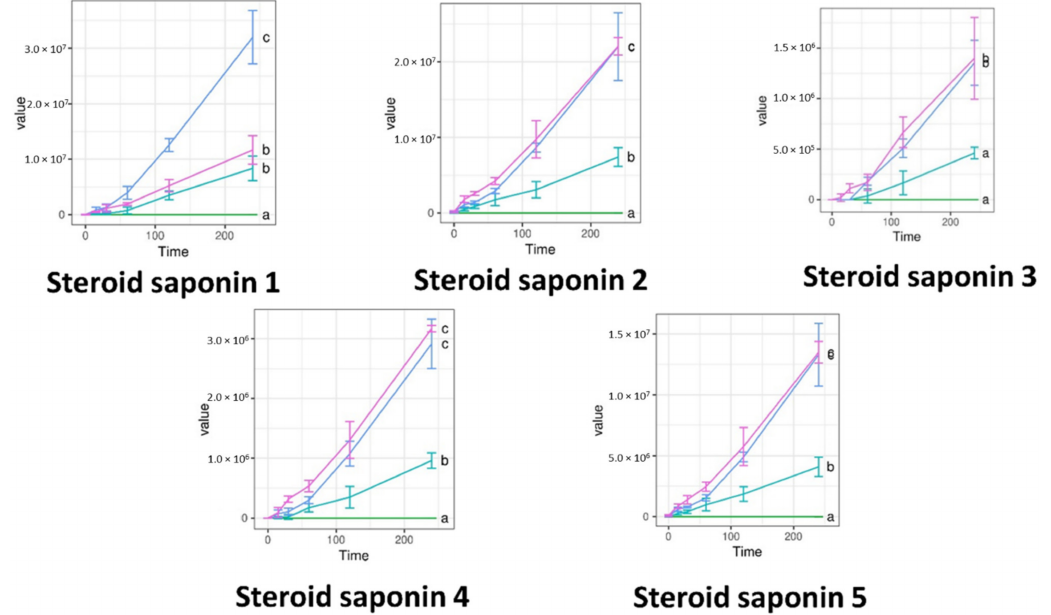
Figure 6. Abundance of Trigonella foenum-graecum compounds in the basal layer of Caco-2 cells, as measured by LC-ESI-MS. Steroid saponins were measured in positive ion mode. Data are given in raw abundance. Abbreviations denote compositions of the upper layer, as in Table 3. The curves marked with different letters differ significantly according to Tukey’s HSD post-hoc